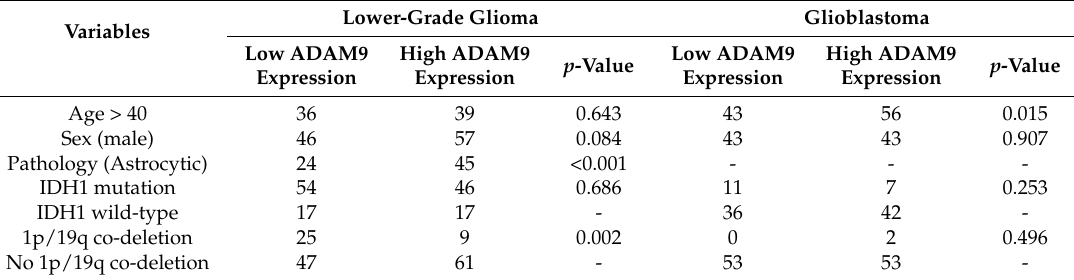
Table 2. Association between ADAM9 expression level and clinical characteristics *.